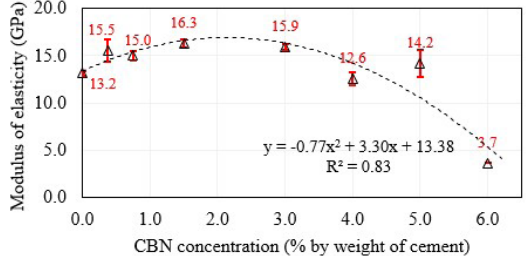
Figure 3. 28-days modulus of elasticity of mortars with different CBN